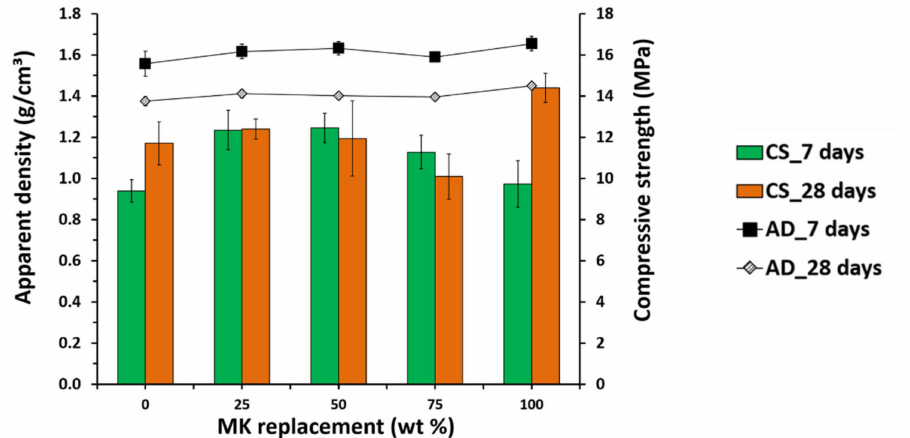
Figure 9. The apparent density and compressive strength of the alkali activated binders at 7 and 28 days of curing as a function of metakaolin replacement by calcined common